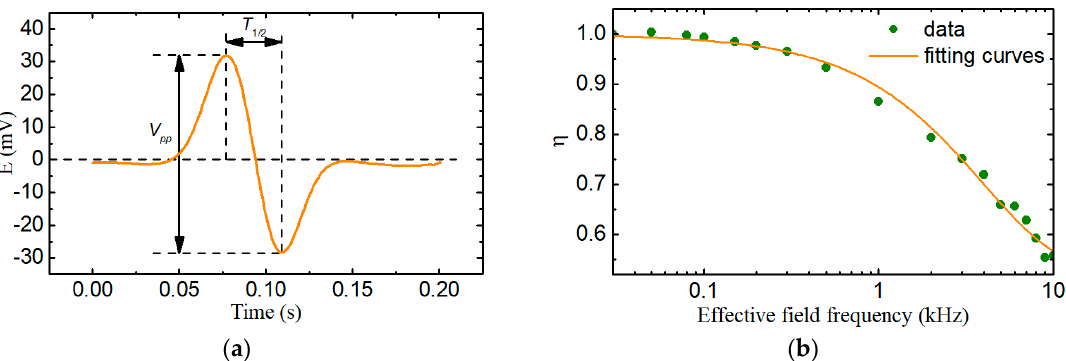
Figure 12. ( a ) A typical particle signal output by the sensor; ( b ) The relative change ratio of the magnetic flux.